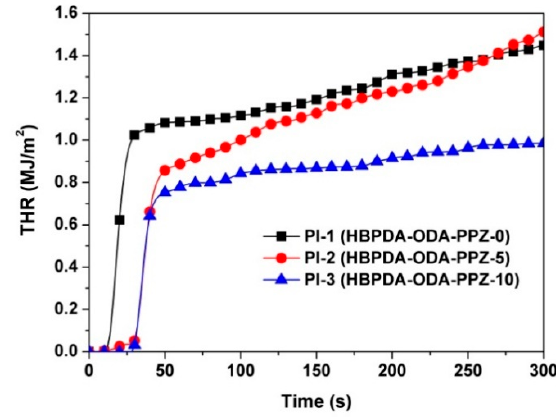
Figure 11. THR plots of PI films.